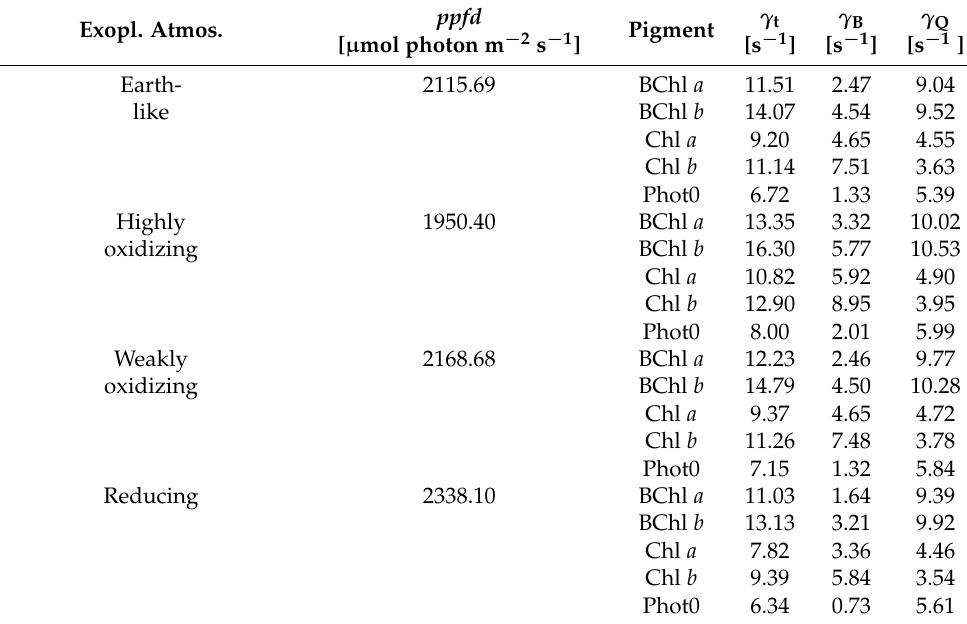
Table 1. Photosynthetic fitness metrics for Earth-like exoplanets with different atmospheres in the middle of the HZ around a G2V star a . Exopl.